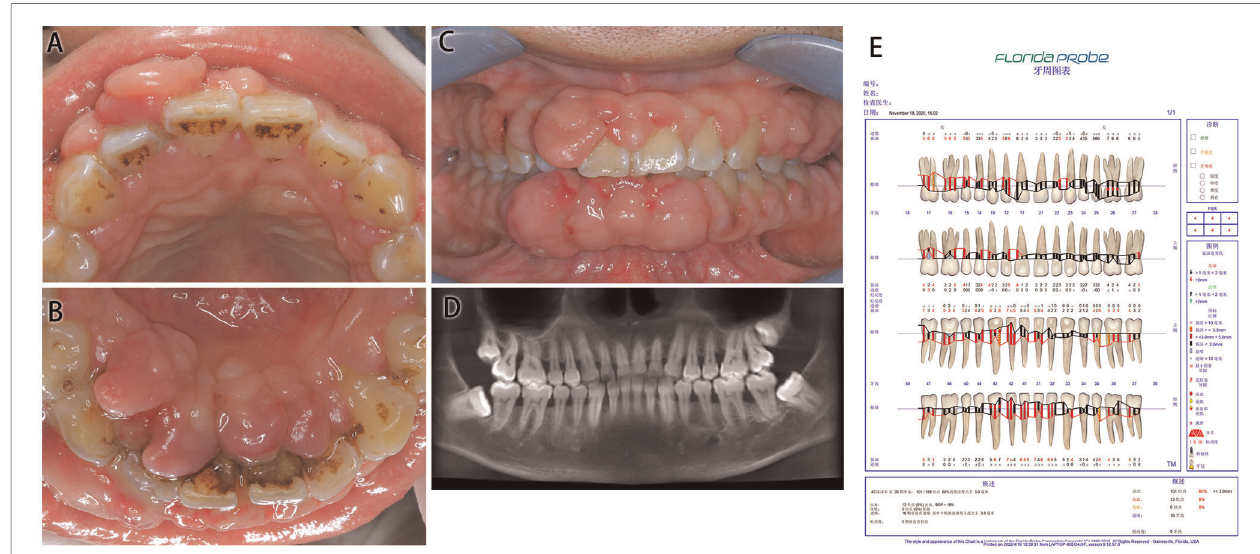
FIGURE 1 | Medical information on Case 1 at fi rst diagnosis (before treatment). ( A ) Maxillary view. ( B ) Mandibular view. ( C ) Frontal view images. ( D ) Radiological images. ( E ) Periodontal examination